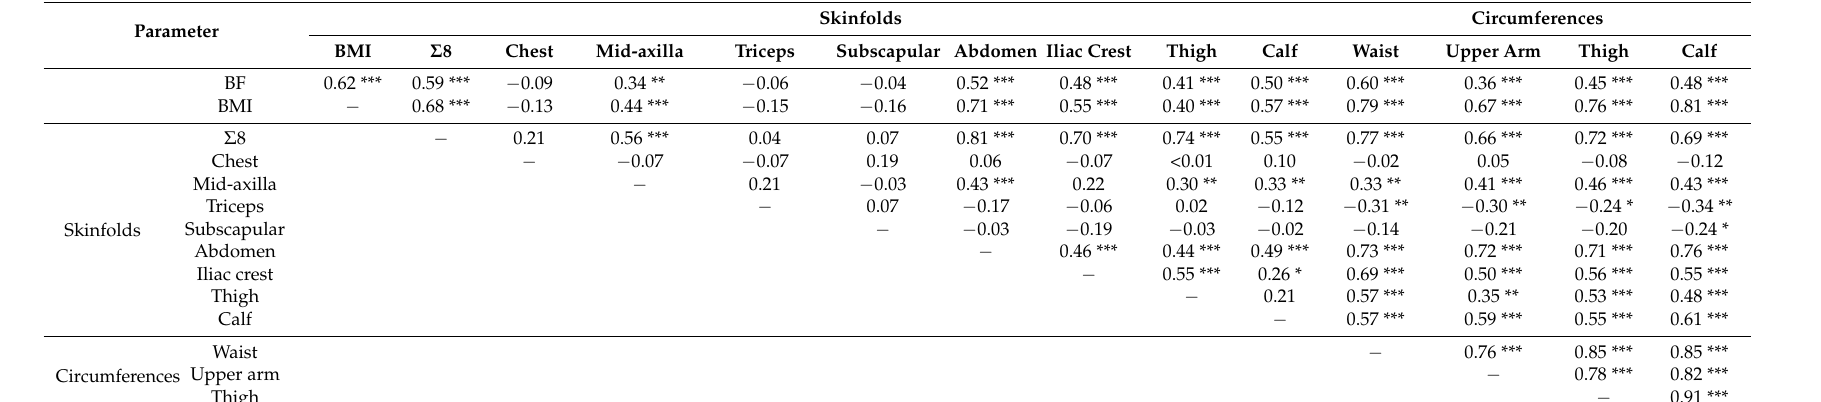
Table 1. Correlations (Pearson r ) among anthropometric